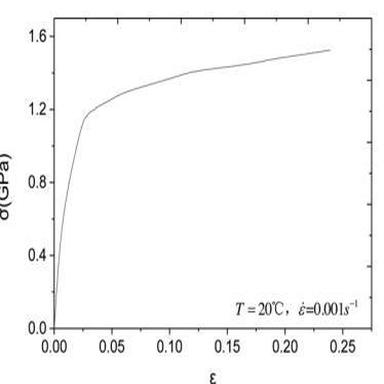
Stress-strain curves under different conditions.